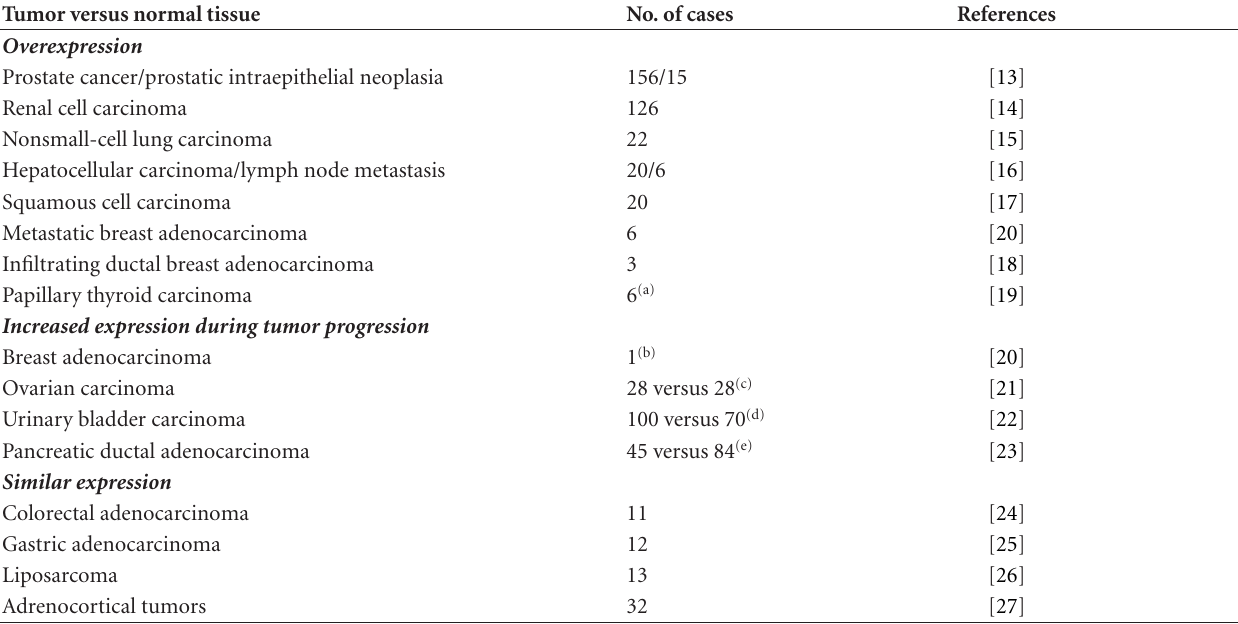
Table 4: PPAR γ expression in human tumor versus normal